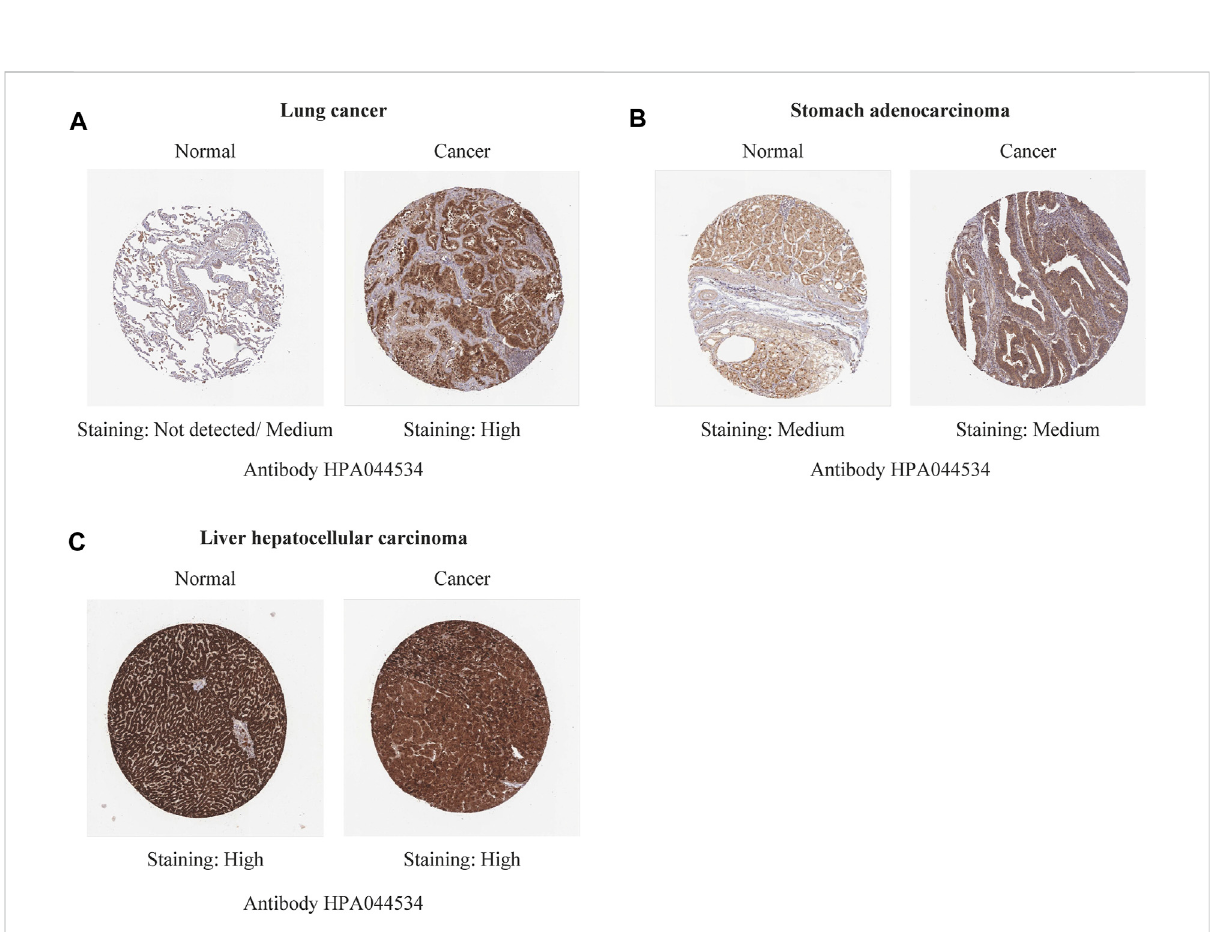
FIGURE 6 The immunohistochemistry staining images of REV1 in different types of tumor tissues and normal tissues [lung (A) , stomach (B) and liver (C)